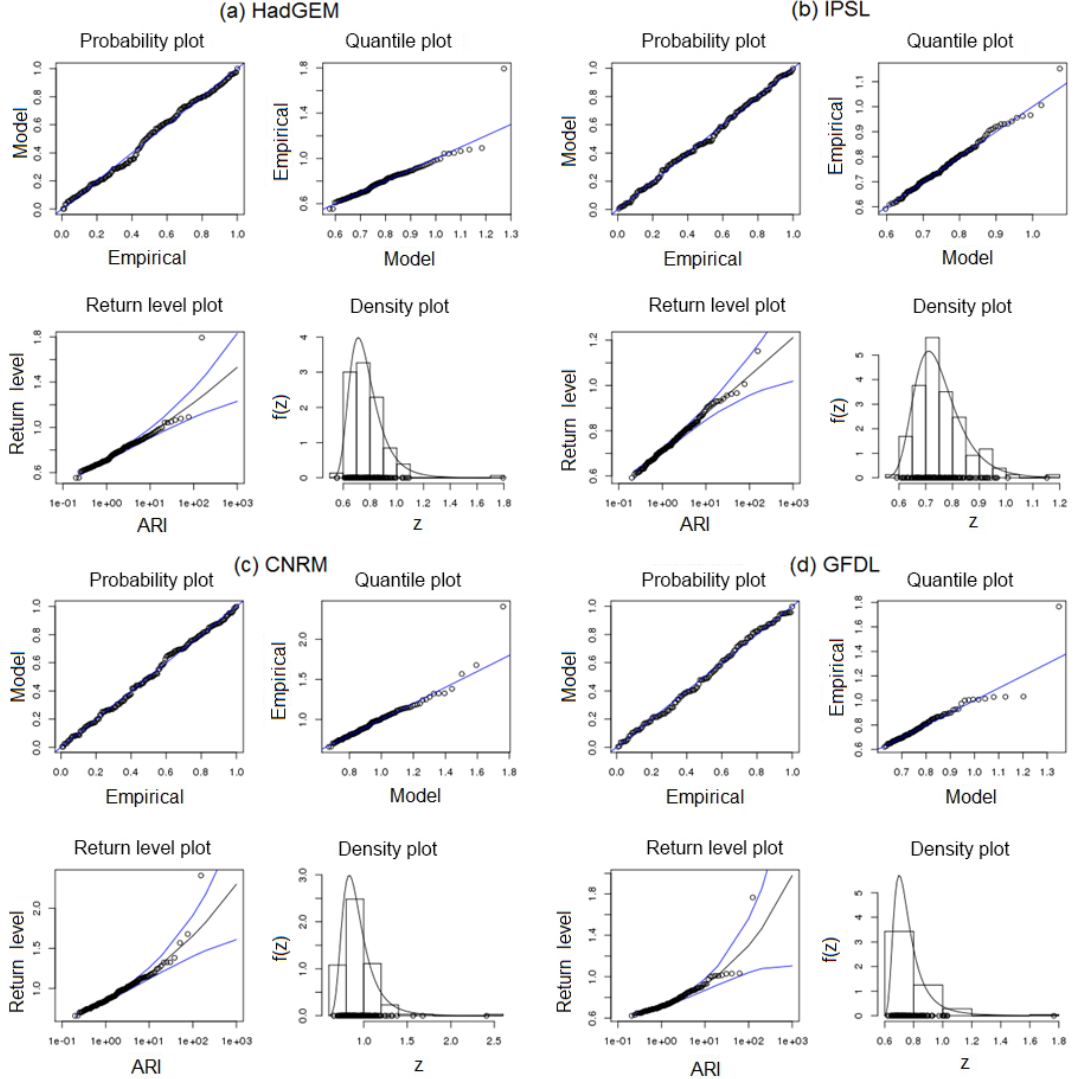
Figure A3. Standard diagnostic plots for stationary fit to significant wave height annual maxima from (a) HadGEM2-ES, (b) IPSL, (c) CNRM and (d) GFDL simulations. The quantile and probability plots compare the theoretical distribution fitted to the data with the actual data and give an indication of confidence in the fit of the return